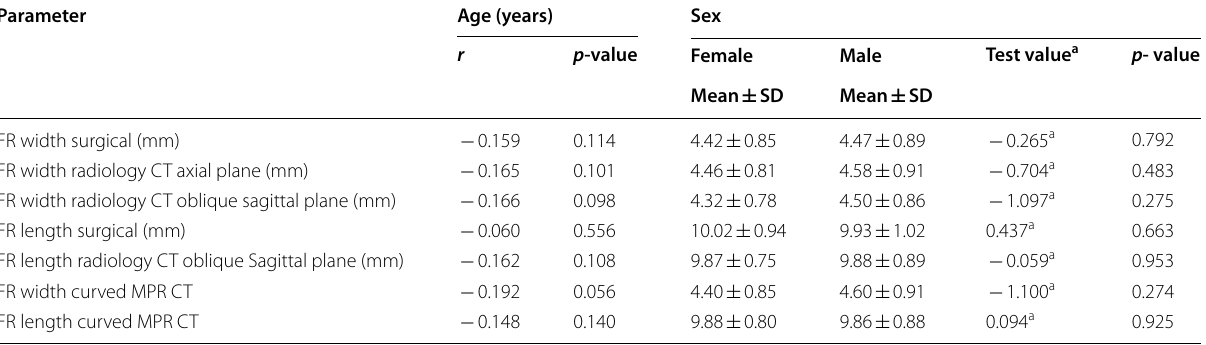
Table 4 Correlation between age and sex on one hand and surgical and radiological measurements on the other hand among the studied